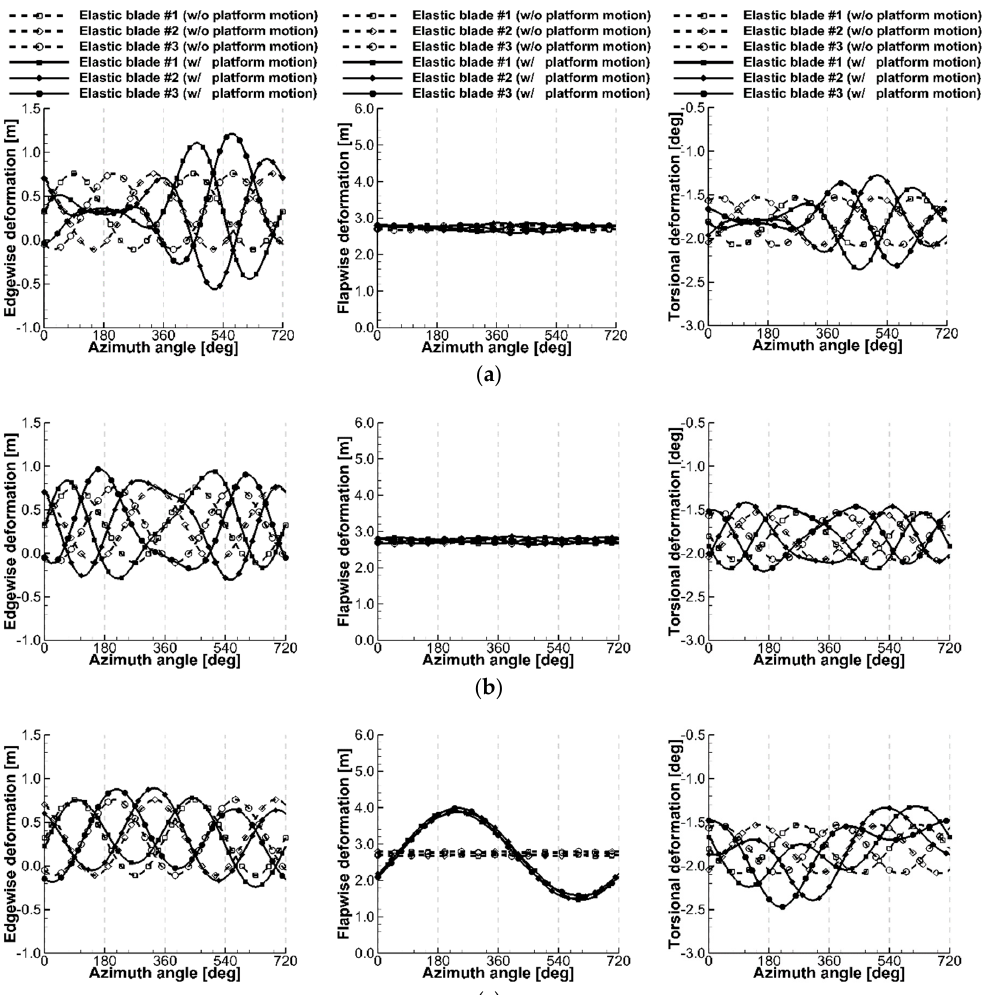
Figure 10. Blade tip deformations under translational platform motions. ( a ) Heave motion. ( b ) Sway motion. ( c ) Surge